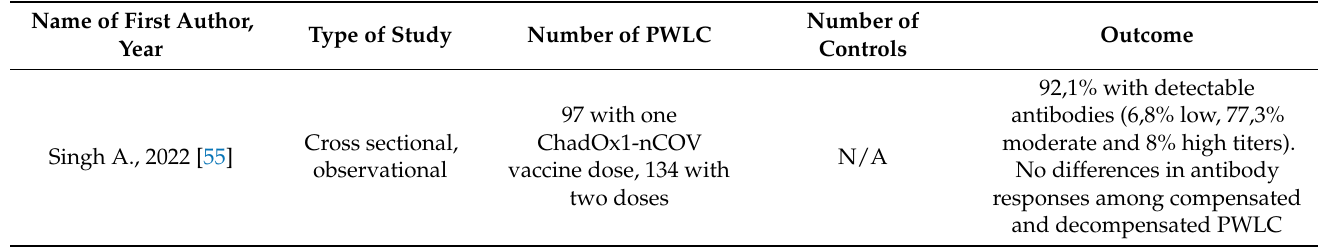
Table 2. Most important studies concerning viral-vector anti-SARS-CoV-2 vaccines in patients with